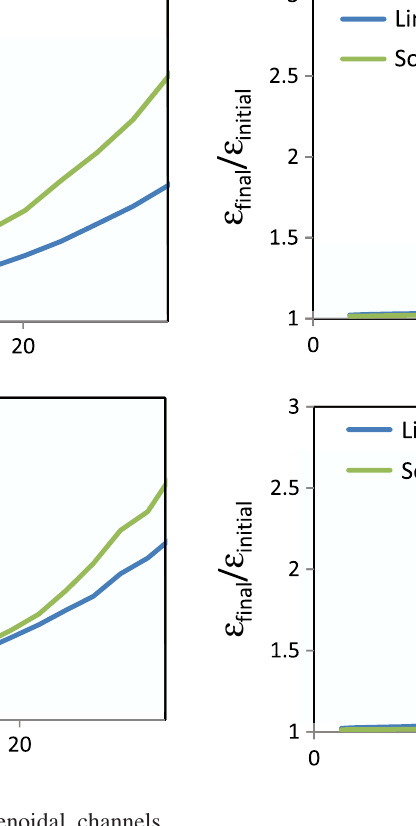
FIG. 9. (Color) Increase of emittance in solenoidal channels, B ¼ 0 : 36 T . Top: initial emittance 8 : 0 (cid:3) mm mrad . Bottom: initial emittance 4 : 5 (cid:3) mm mrad